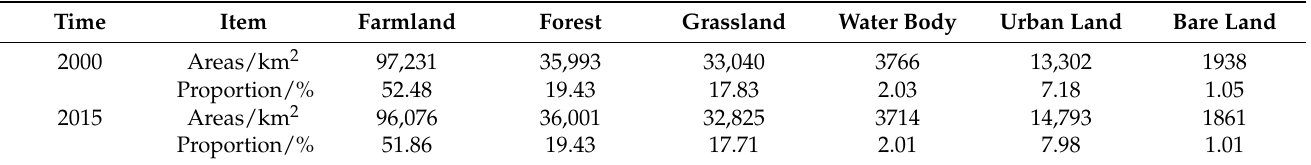
Table 4. Land-use structure in Hebei of 2000 and 2015.